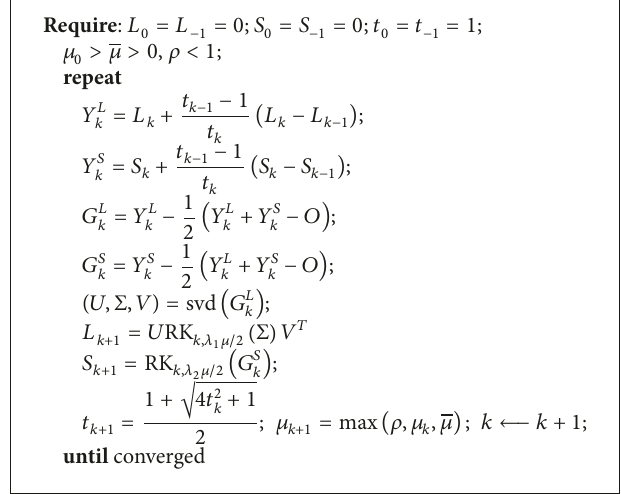
Algorithm 1: An efficient minimization scheme with regular 𝑘 -shrinkage thresholding